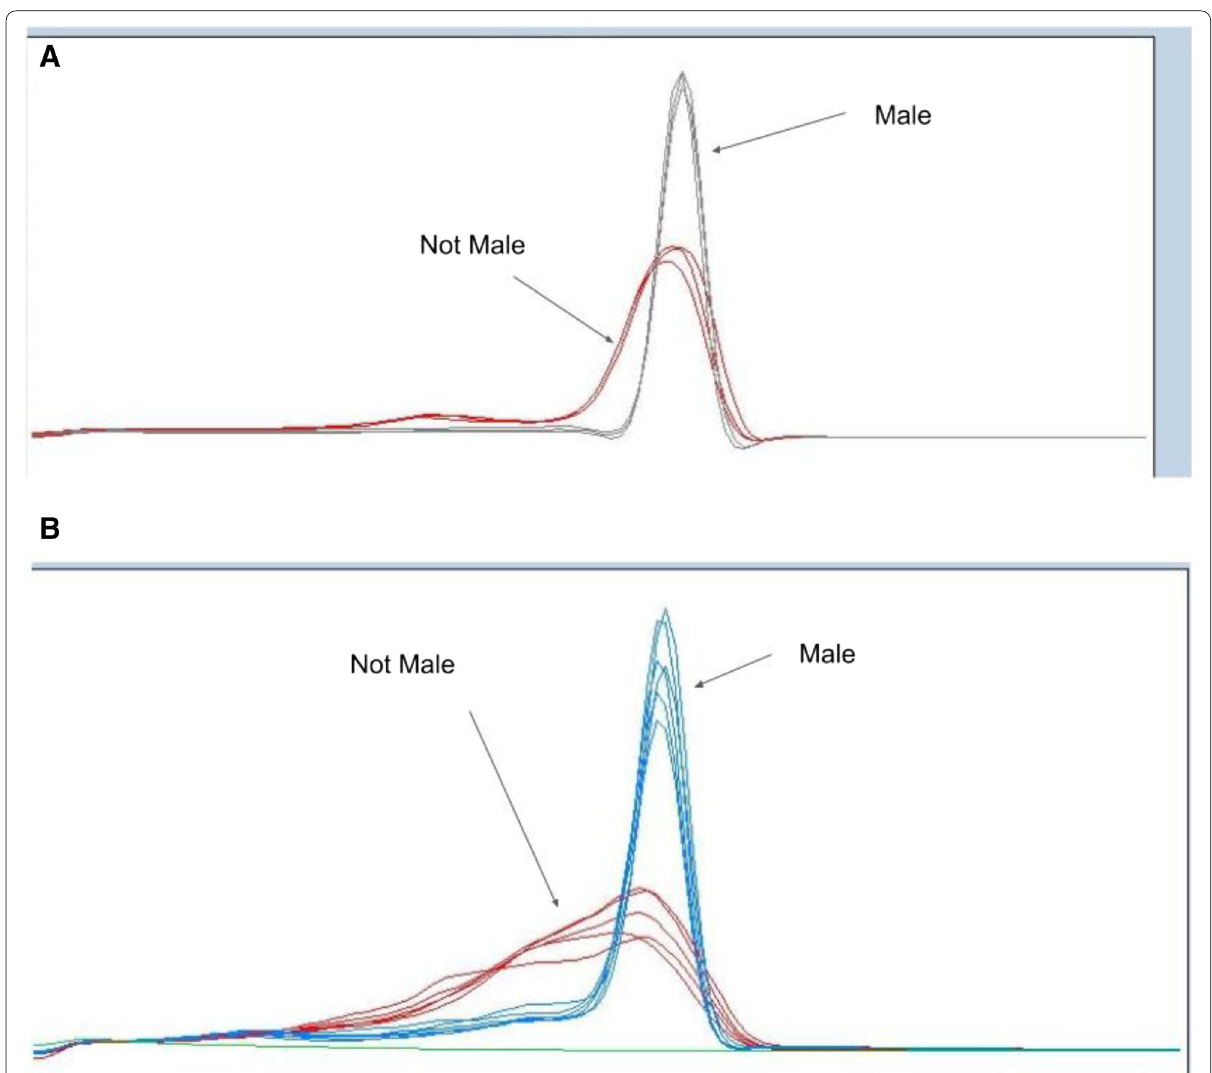
Fig. 2 High-resolution melt (HRM) curve profiles from sex markers derivatized high-resolution melting analysis curves on selected Cannabis sativa male and not male samples from the SexID Steep Hill high-throughput testing sample